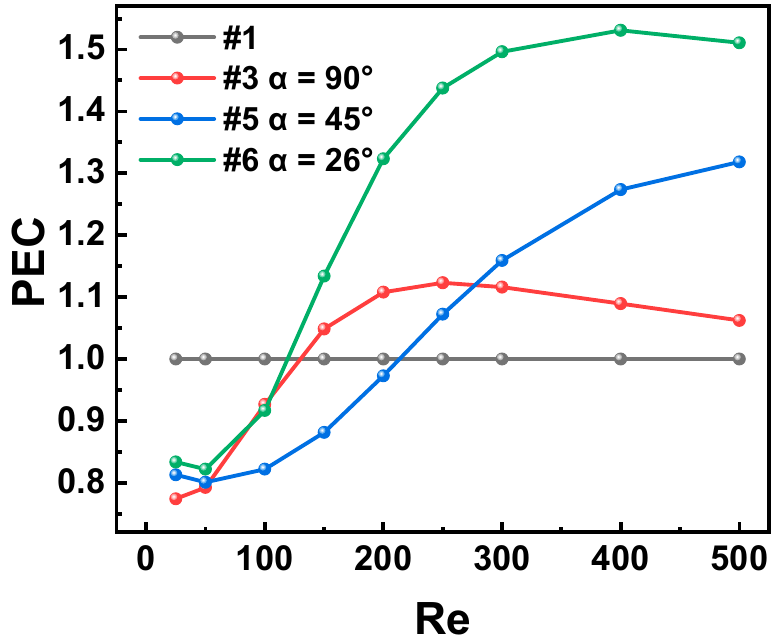
Figure 8. PEC versus Re with different fin incident angles.